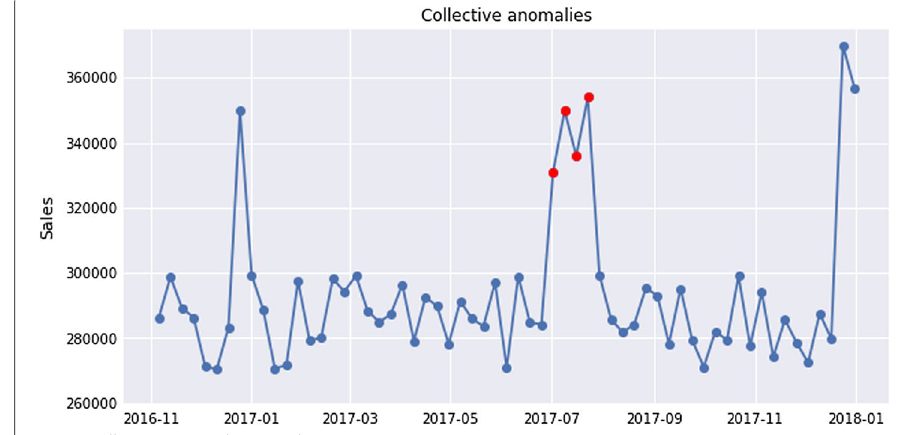
Fig. 4 Collective anomaly example [4]